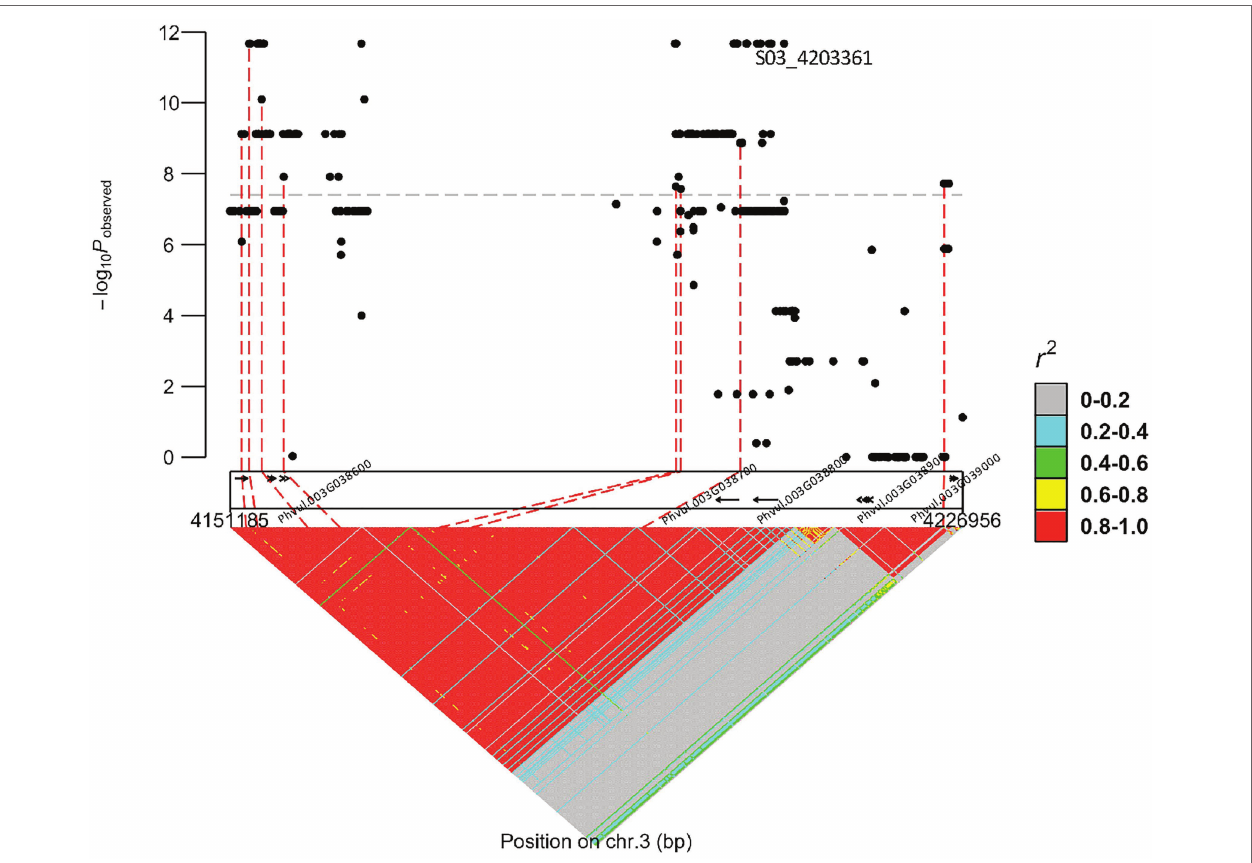
FIGURE 2 | bc-1 regional marker-trait associations plot depicting the receptor-like protein kinases (RLK) candidate genes (arrows) for bc-1 inside the dotted box